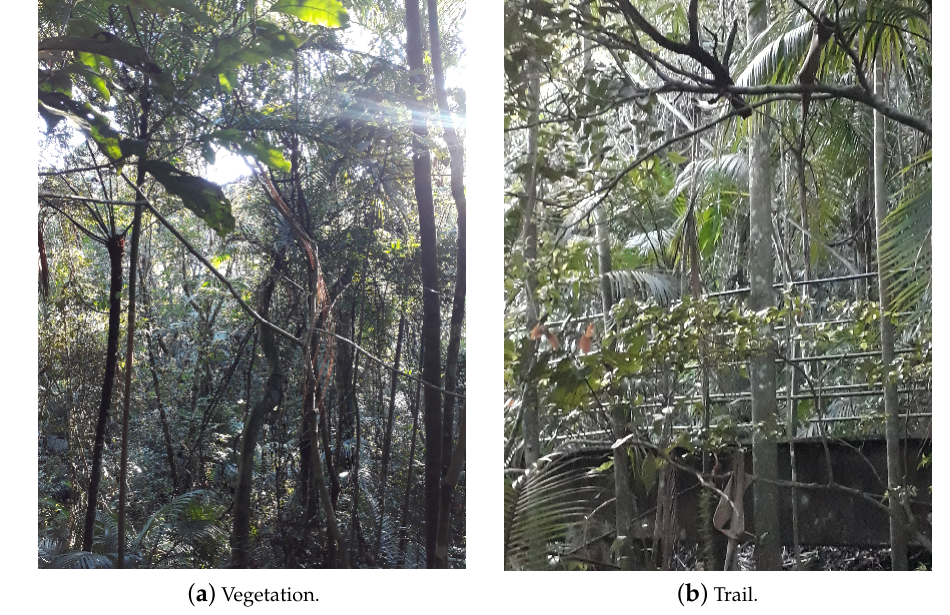
Figure 1. Vegetation and experiment